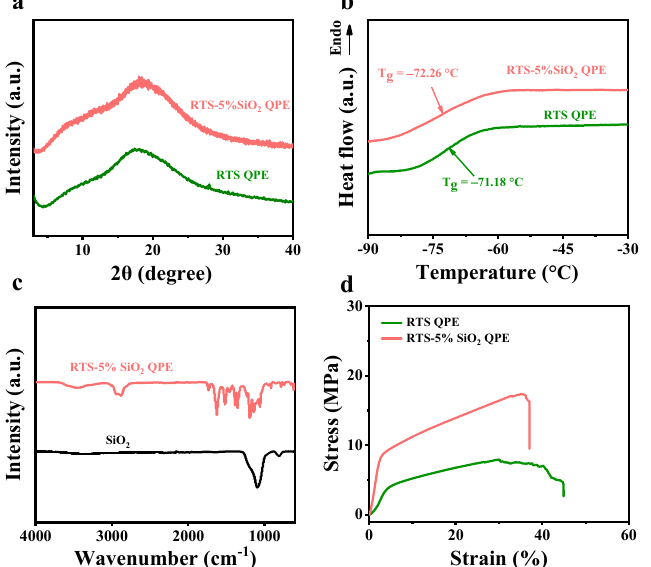
Figure 3. Physical characterization of RTS QPE and RTS-5% SiO 2 QPE. ( a ) XRD spectra; ( b ) DSC curves; ( c ) FTIR spectra; ( d ) Stress–strain curves.